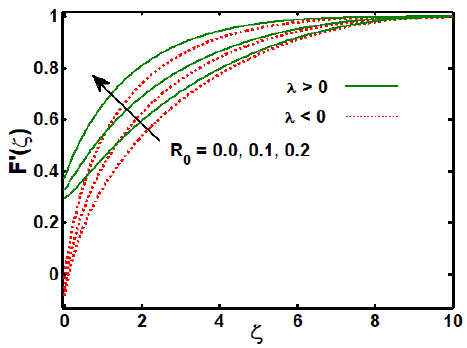
R 0 and 𝐾 0 on the 𝐹′(𝜁) . Figure 2. E ff ects of the R 0 and K 0 on the F (cid:48) ( ζ ) . Figure 2. Effects of the Figure 2. Effects of the